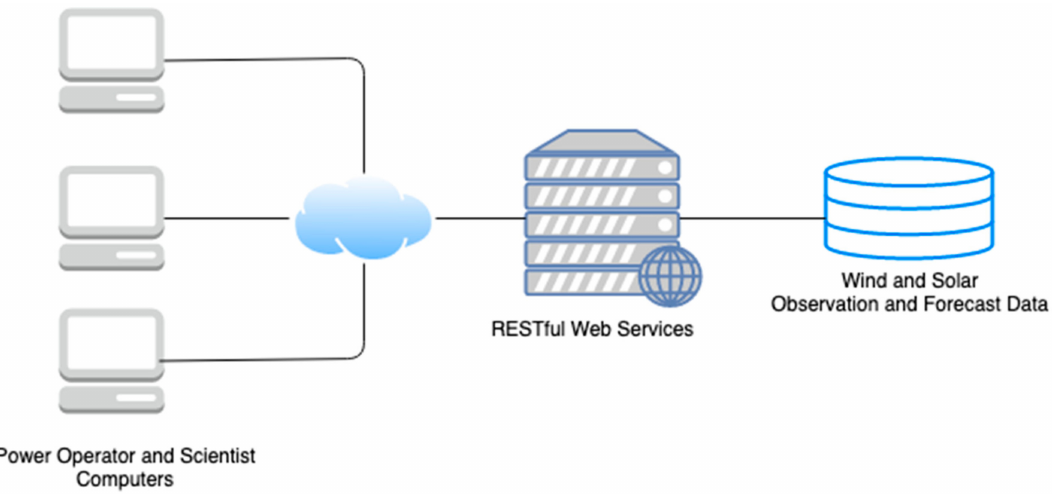
Figure 16. The architecture of the KREPS display.